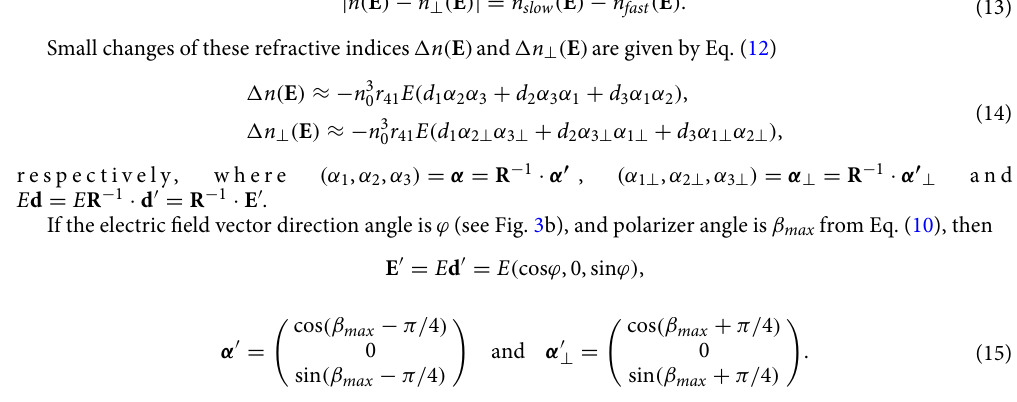
. ′ ′ and α whose directions are given by the semi-axes of ⊥ ( E ) , respectively, that are subjects of the rule ⊥ ( E ) are given by Eq. (12) ⊥